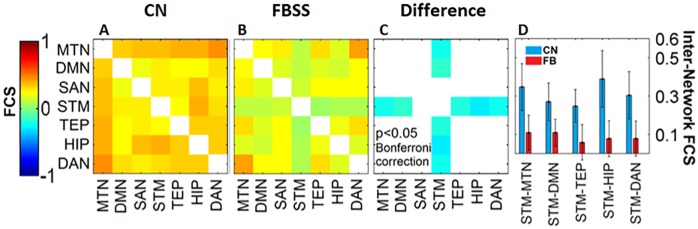
Cross-network FC among RSNs for CN group (A), FBSS group (B), and difference (C), respectively.A color bar (left) shows the color and associated value of FC. D. Bar graph with mean and standard deviation values of FC between STM and MTN, DMN, TEP, HIP and DAN for the CN group (blue) and FBSS group (red).